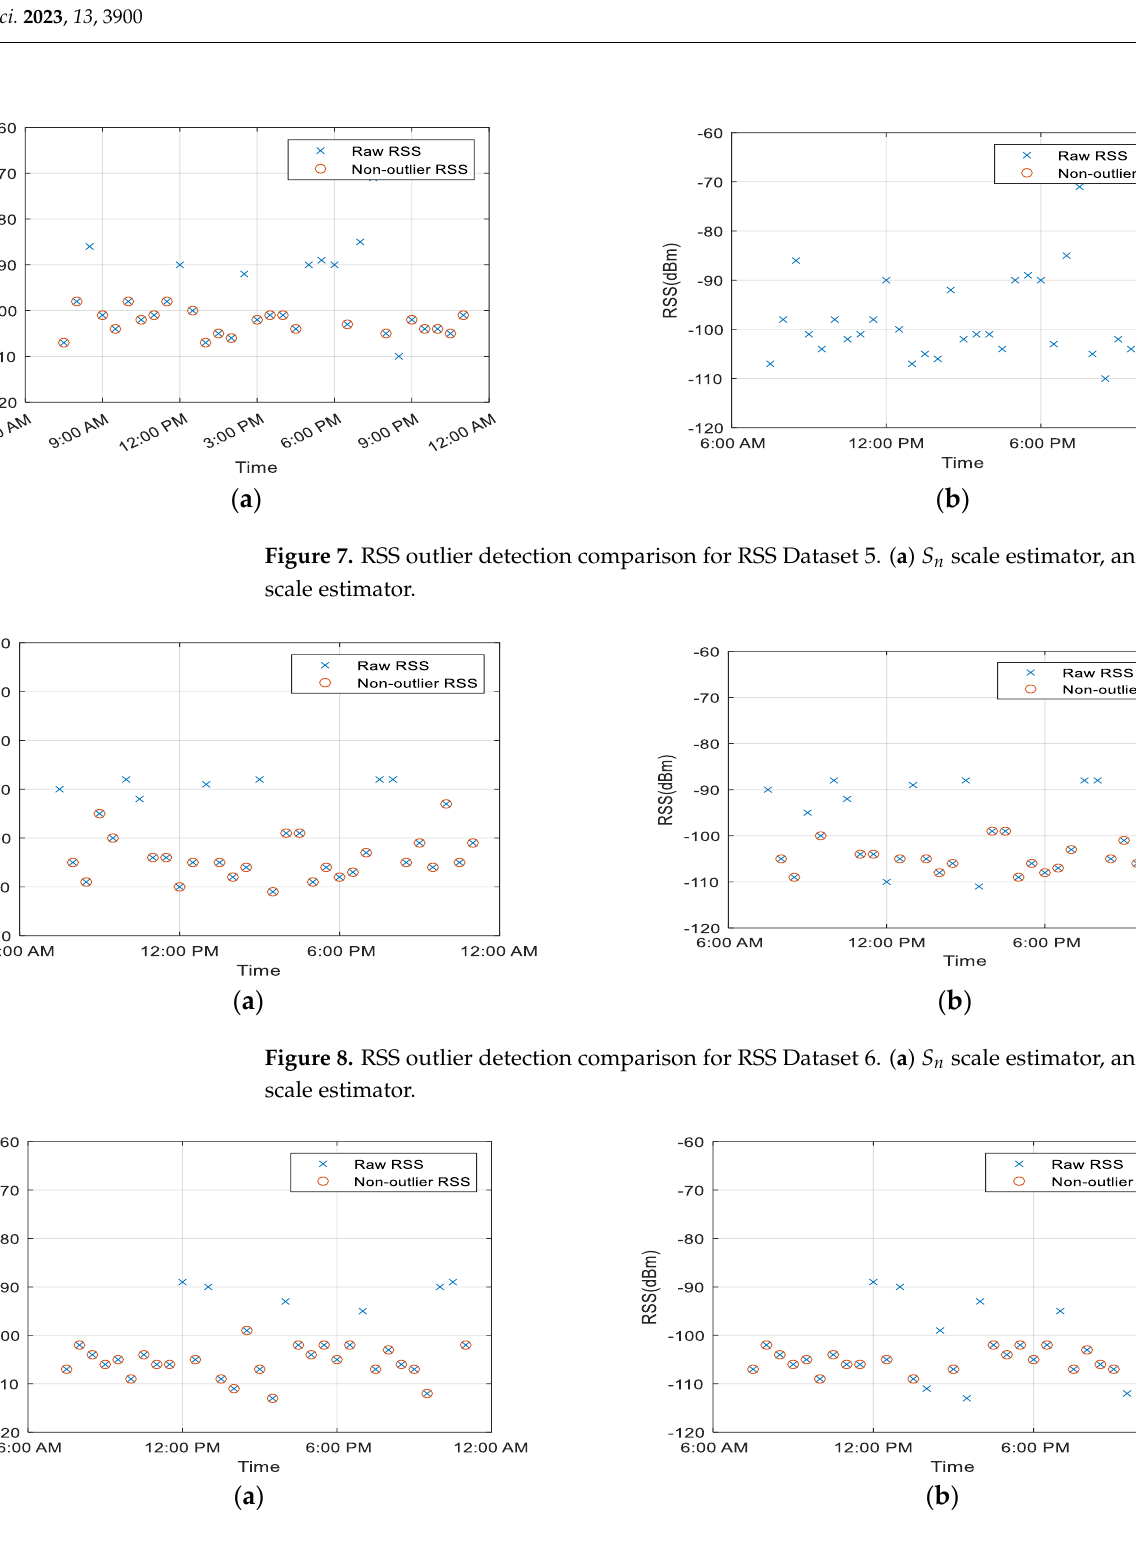
( b ) Figure 10. RSS outlier detection comparison for RSS Dataset 8. ( a ) 𝑆 𝑛 scale estimator, and ( b ) MAD scale estimator. Looking at the distribution of RSS observations for each dataset, it is possible that very few, if any, of the RSS observations could be considered outliers. Both methods iden- tified some RSS observations as outliers. As shown in Table 2, the Z-score method using the MAD as a scale estimator identified at least 50% of the observations in each dataset as outliers. On the other hand, the Z-score method with the 𝑆 𝑛 scale estimator identified, on average, 13% of the observations in each dataset as outliers. This implies that the Z-score method based on the MAD scale estimator considered several valid RSS observations as outliers, demonstrating its inefficiency when applied to time-series RSS observations. A number of factors could contribute to such inefficiency. The first one includes the previ- ously mentioned high gross error sensitivity. The second is its symmetrical approach to detecting outliers from observation medians, which is inefficient when applied to an asymmetrical observation, such as time-series RSS observations. Table 2. Comparison of the number of detected outliers. RSS Dataset 𝑺 𝒏 Scale Estimator MAD Scale Estimator No. of Outlier Detected % of Total Observation No. of Outlier Detected % of Total Observation 1